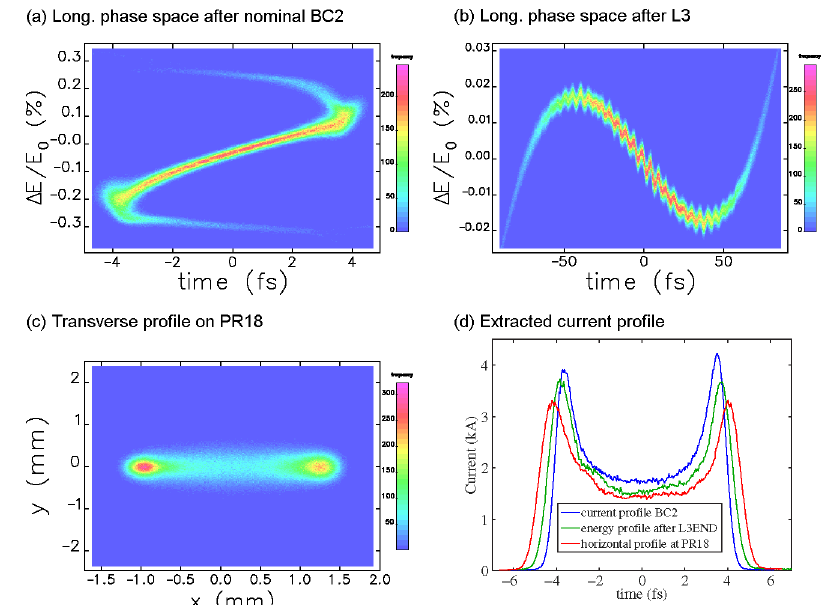
FIG. 6. ELEGANT simulation for an undercompressed 20-pC bunch (L2 phase (cid:7) 2 ¼ (cid:2) 31 : 5 (cid:10) ), including CSR effects in bends, wakefield, and LSC in linacs.